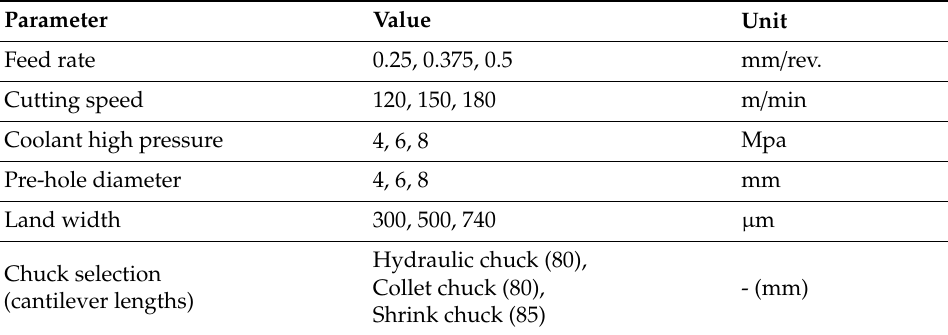
Table 1. List of varied